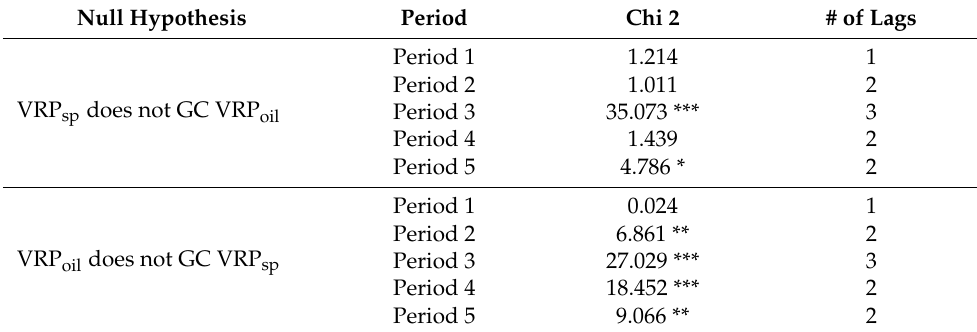
Table 7. Granger causality tests for sub-periods.